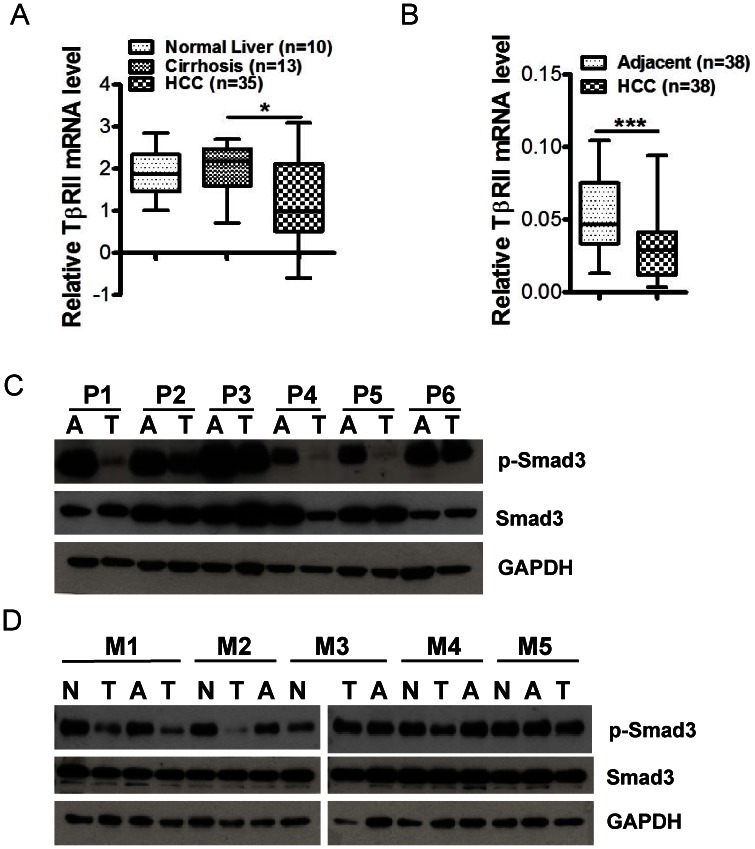
Down-regulation of TGFβ signaling pathway in human and mouse HCCs.(A) Significant decrease of TβRII expression in HCC compared with cirrhosis was seen in the report from Oncomine™. Shown are box-whisker plots of relative TβRII mRNA levels in human tissue. *, p<0.05 with one-way ANOVA. (B) Quantitative real-time PCR displayed significant reduction on TβRII expression in human HCC compared with precancerous tissue. Shown are box-whisker plots of the value of relative TβRII mRNA expression compared with GAPDH. ***, p<0.001. (C) Immunoblotting analysis of p-Smad3 and total Smad3 expression in paired human HCC (T) and adjacent tissues (A). (D) Immunoblotting analysis for p-Smad3 and total Smad3 expression in paired mouse HCC (T), Normal liver (N), and normal tissue adjacent to HCC (A). Mouse 1 had two live tumors.